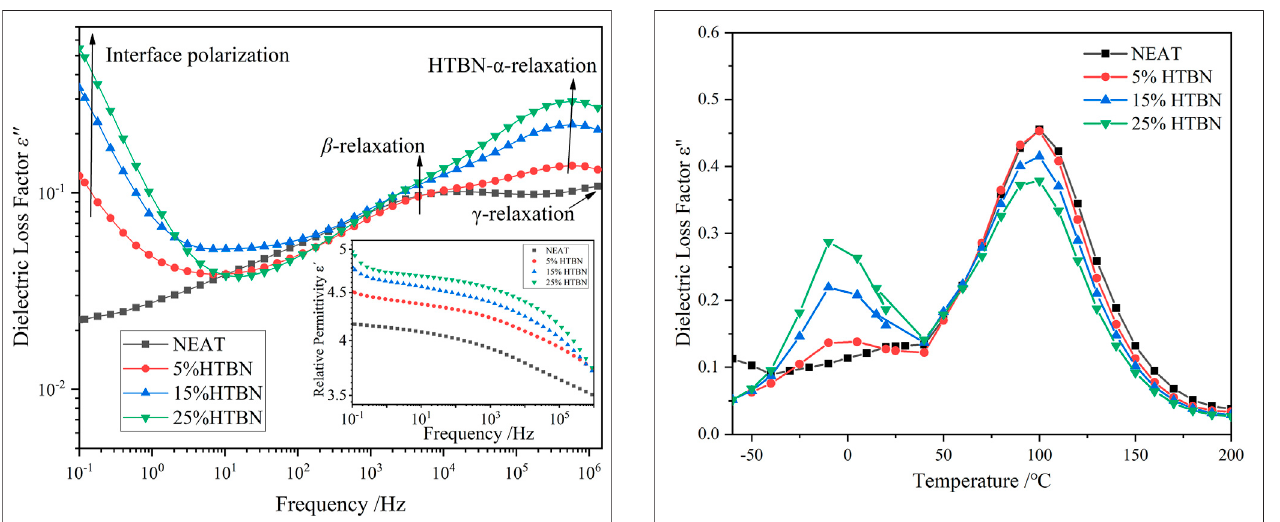
Frontiers in Chemistry |